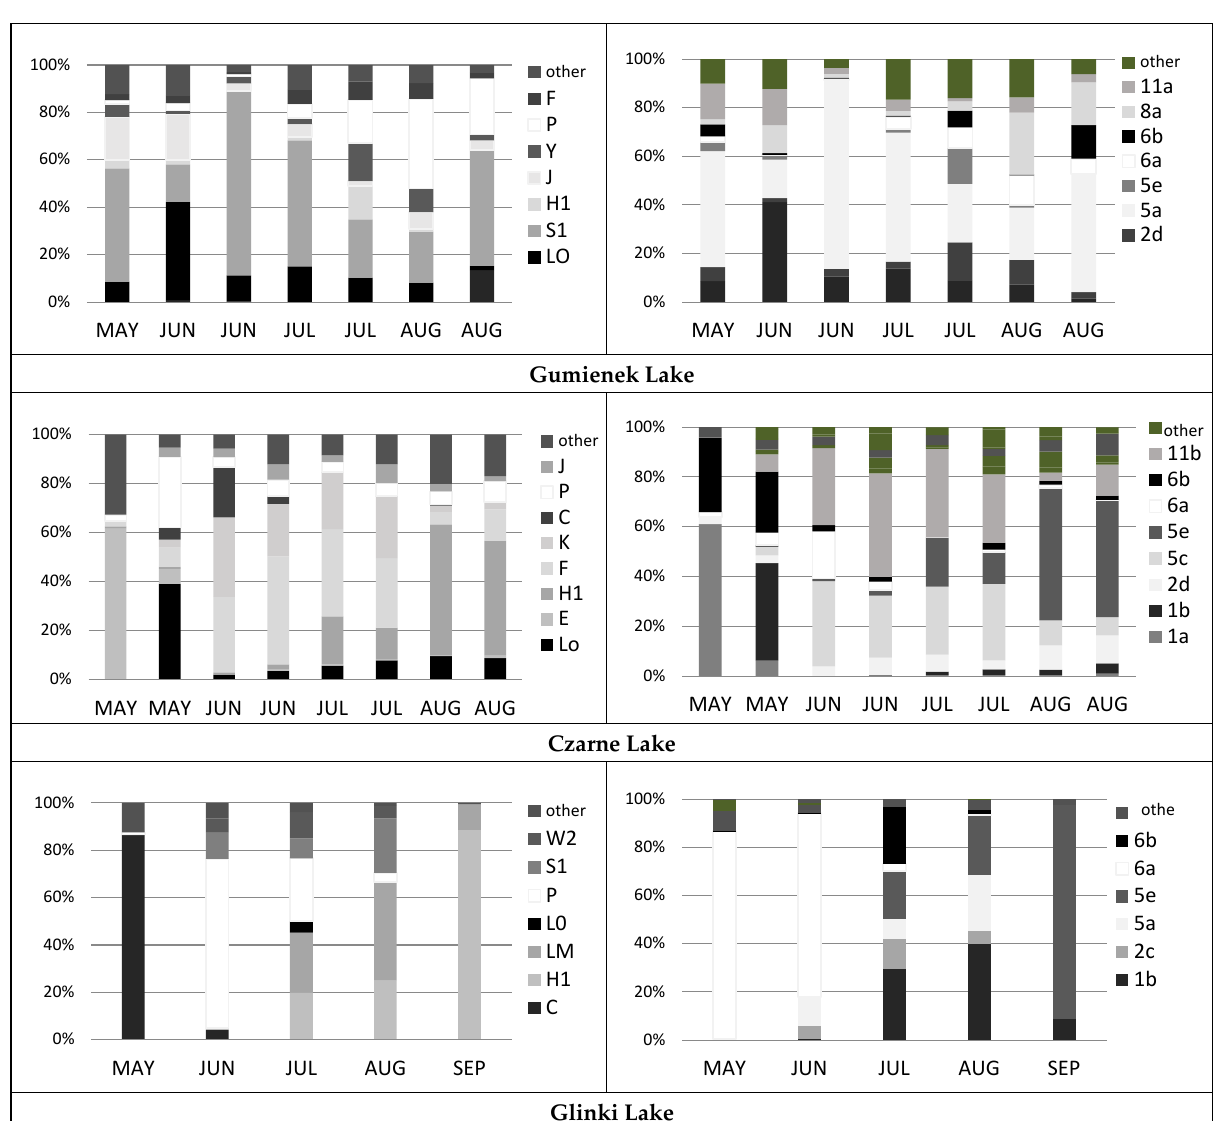
Figure 2. Percentage shares of functional (left column) and morpho-functional (right column) groups—FGs and MFGs in the studied lakes in the following month of study. Abbreviations: MAY–May, JUN–June, JUL–July, AUG–August, SEP–September.